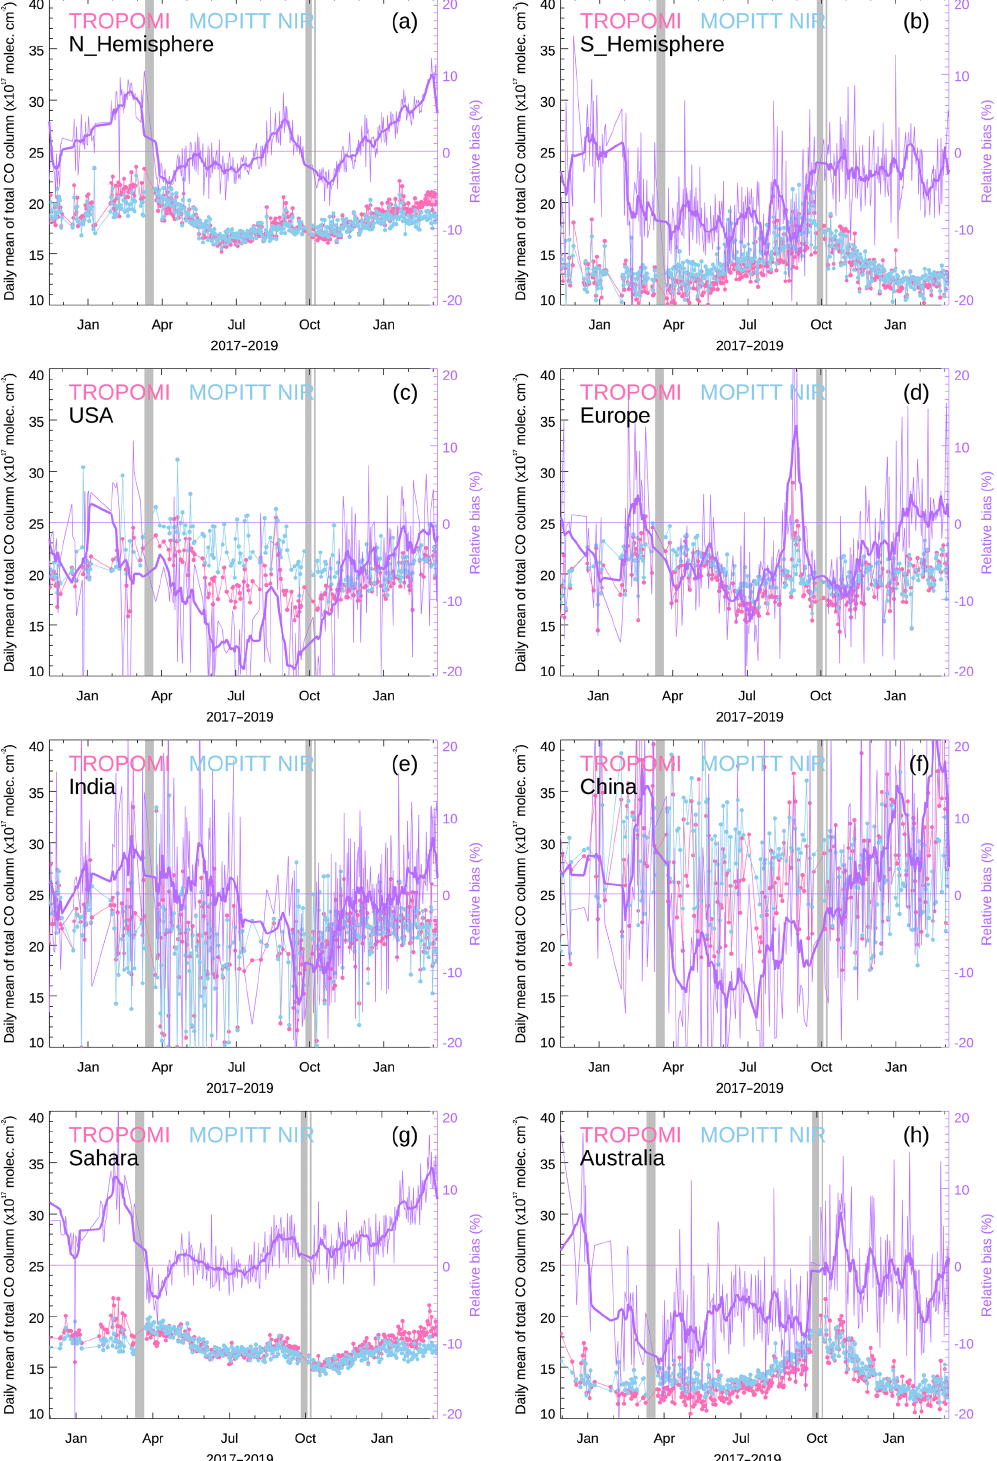
Figure 4. Comparison of colocated land retrievals from TROPOMI (pink) and MOPITT NIR (blue) for each ROI analyzed. See caption to Fig. 3 for